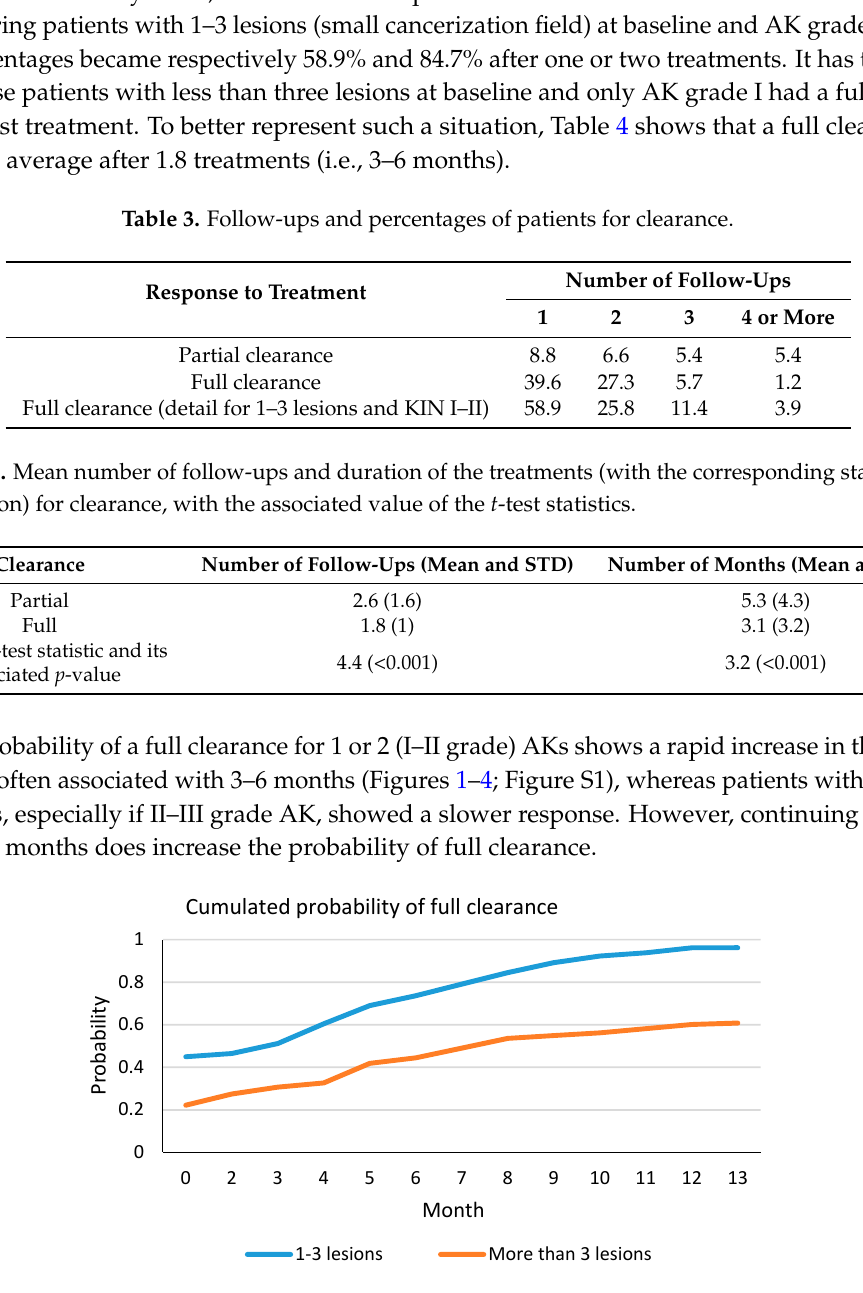
Figure 1. Probability of full clearance for number of lesions, according to the treatment duration (in months).